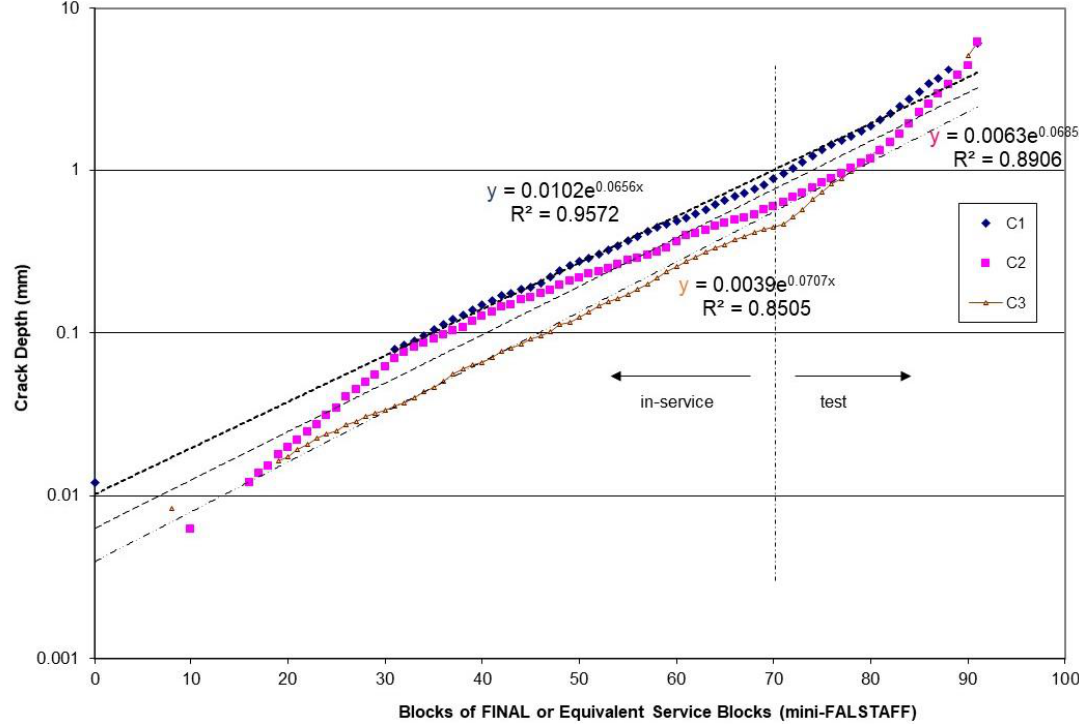
Figure 7. Fatigue crack growth for the three cracks C1, C2 and C3 in the Y470 bulkhead flange. The zero time intercepts obtained from the regression equations represent the EPS values for each of the cracks, from [14].